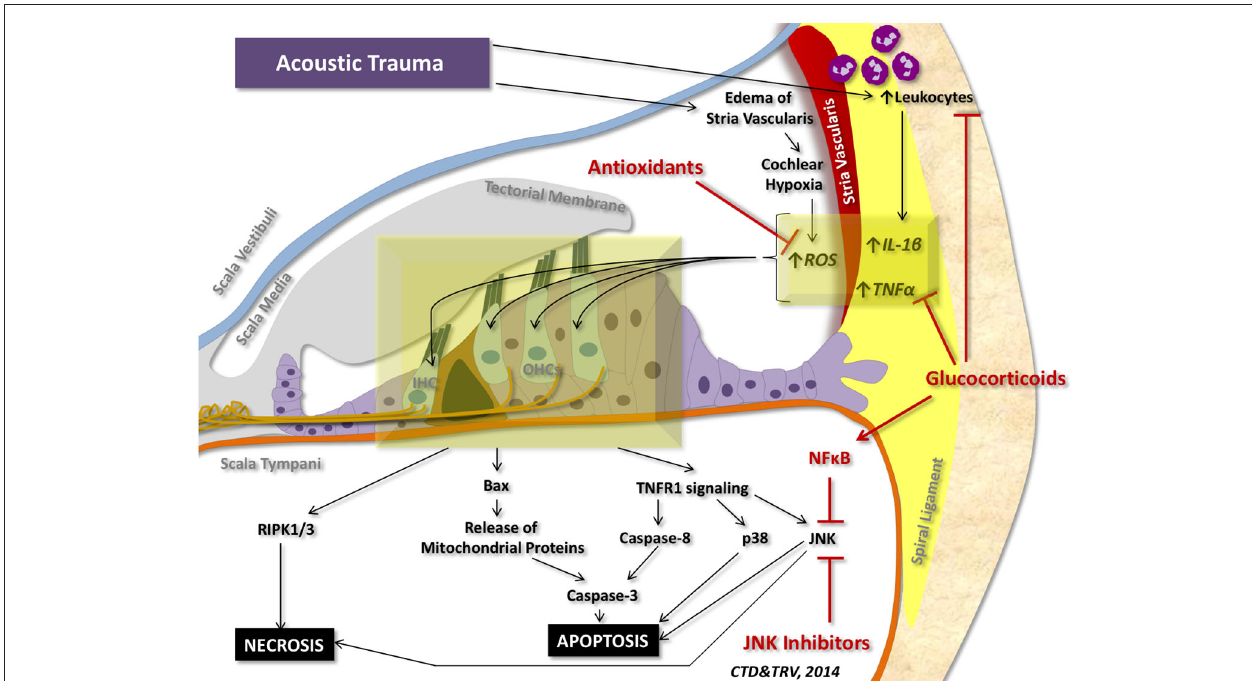
apoptotic signaling cascades. Prolonged activation of JNK and induction of RIPK1/3 activity can promote necrotic cell death. Glucocorticoids have demonstrated protection against acoustic trauma, in part by reducing leukocyte migration, decreasing expression of pro-inflammatory factors, and activating NF κ B inhibition of JNK signaling. Antioxidants and free radical scavengers can neutralize ROS and downstream effects of oxidative stress. Inhibitors of JNK can also mitigate noise-induced loss of auditory HCs by preventing downstream signaling cascades that lead to apoptosis and